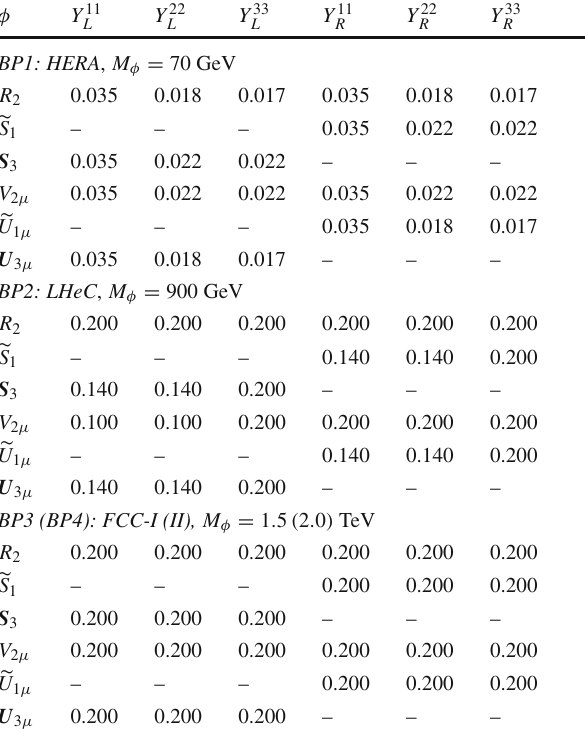
Table 2 Chosen couplings to different generations of quarks and lep- tons for various leptoquarks satisfying the experimental bounds dis- cussed in Sect. 3